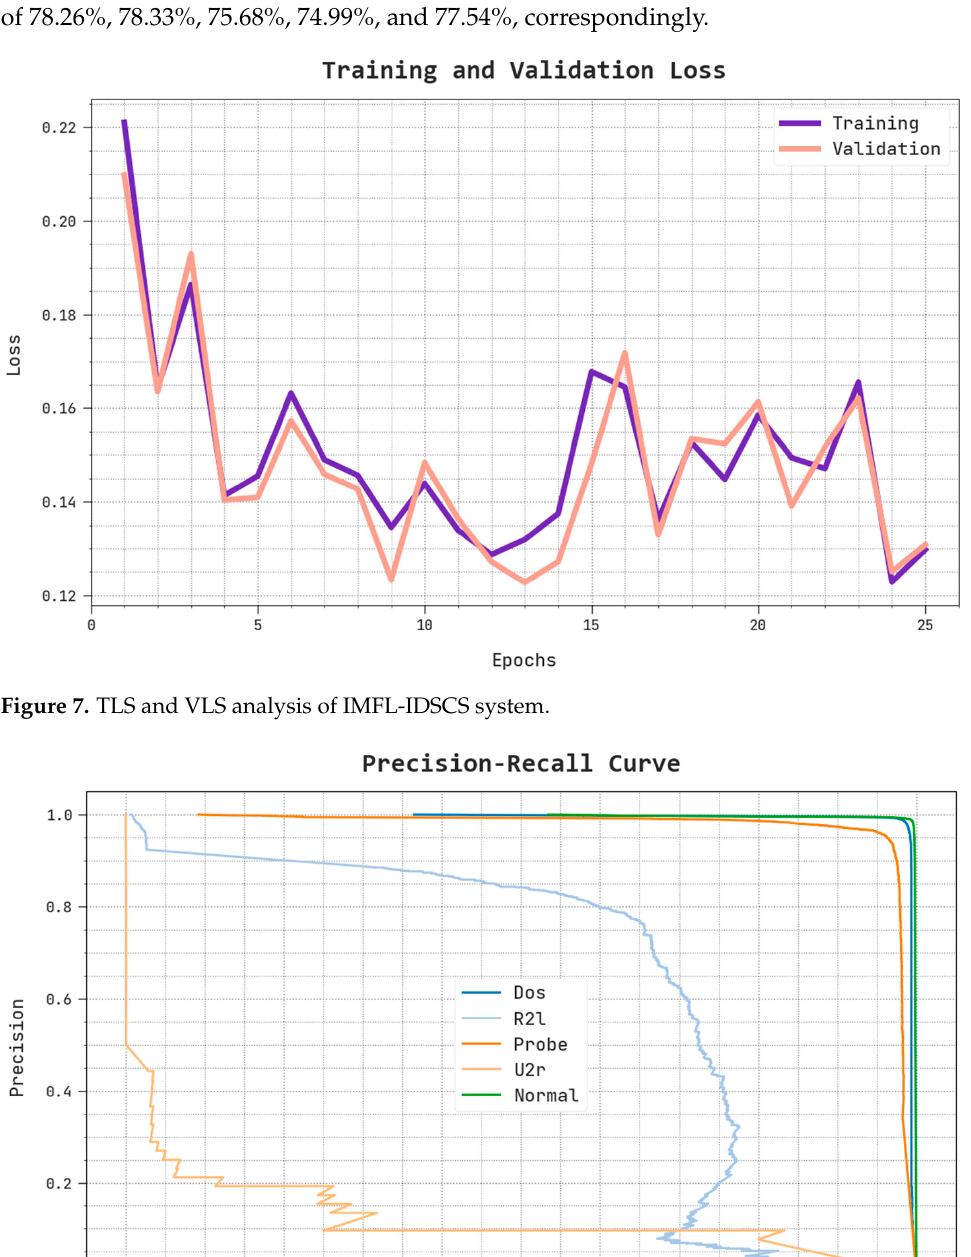
Figure 8. Precision–recall analysis of IMFL-IDSCS system.